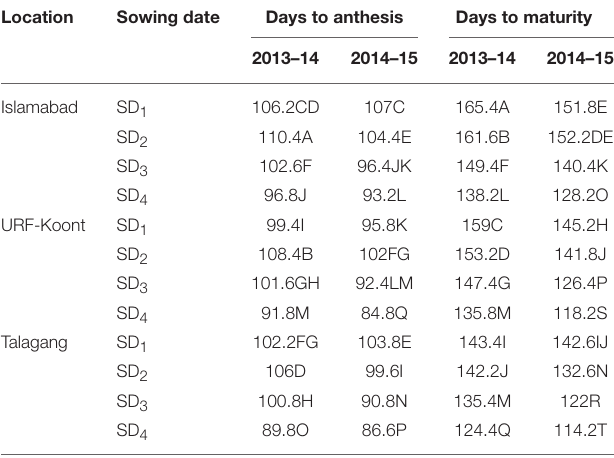
TABLE 4 | Observed wheat phenological development at the three study sites, including four sowing dates (SD) and 2 years. Location